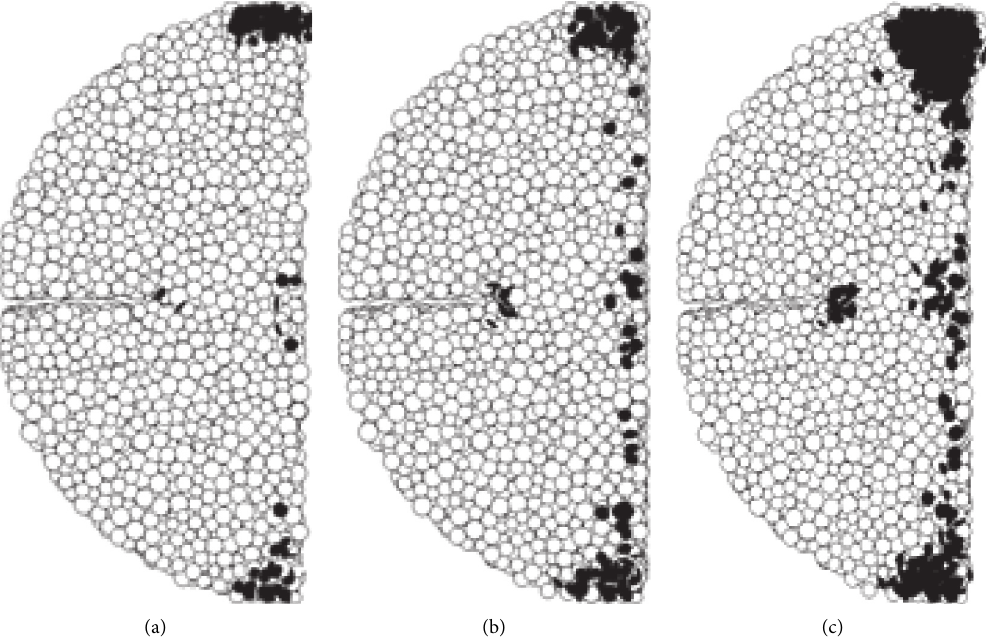
Figure 17: Microcracks distribution in ECFSD specimen (B2). (a) Crack initiation. (b) Crack growth. (c) Sample